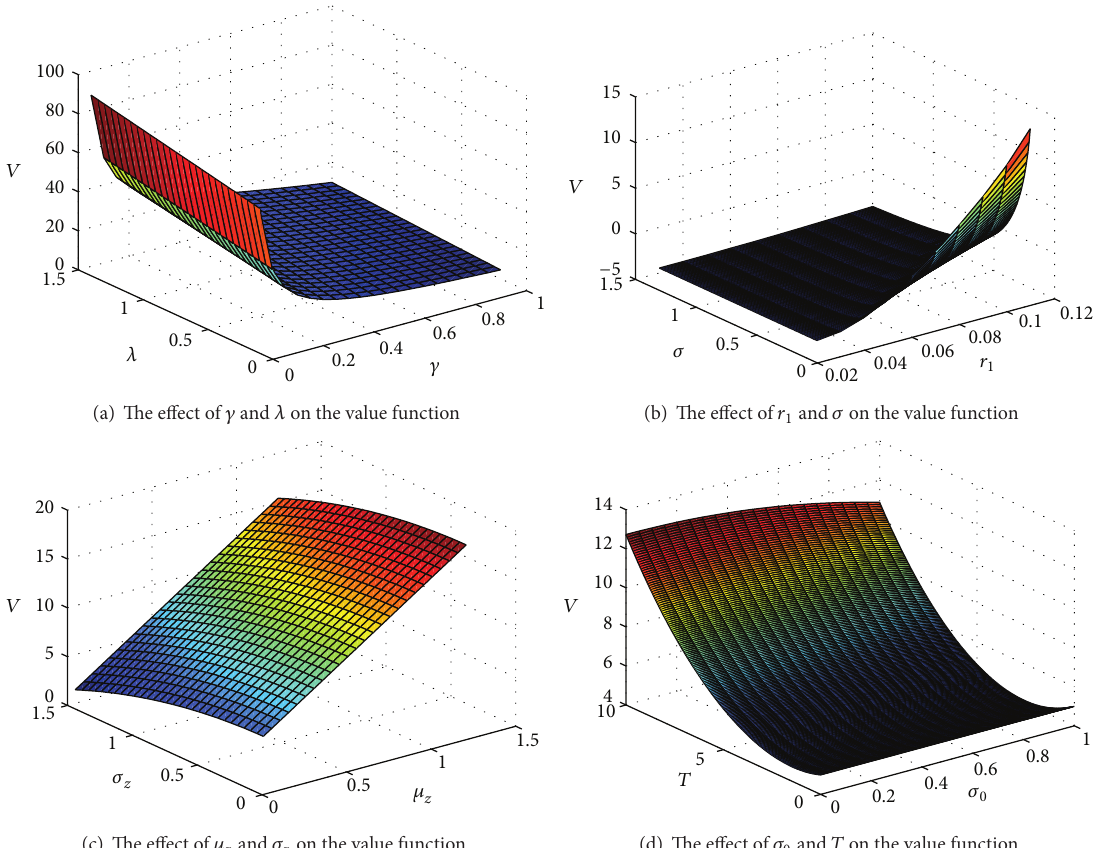
Figure 3: The effect of parameters on the value